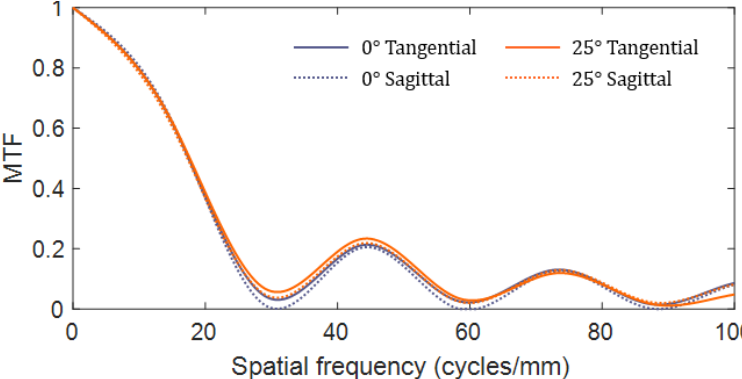
Figure A1. Tangential and Sagittal MTF of the S subsystem at 0 ◦ and 25 ◦ . We see in the plot that the MTF curves with the free-form reflector seem almost identical. The likeness of the sagittal and tangential MTF curves suggests that we have a nice circular blur. This is maintained both with an on-axis and with a 25 ◦ inclination, which testifies for a uniform blur spot throughout the surface of the retina. Note that, without the free-form reflector, our subsystem would have suffered from two main types of aberrations: strong astigmatism and field curvature (not shown